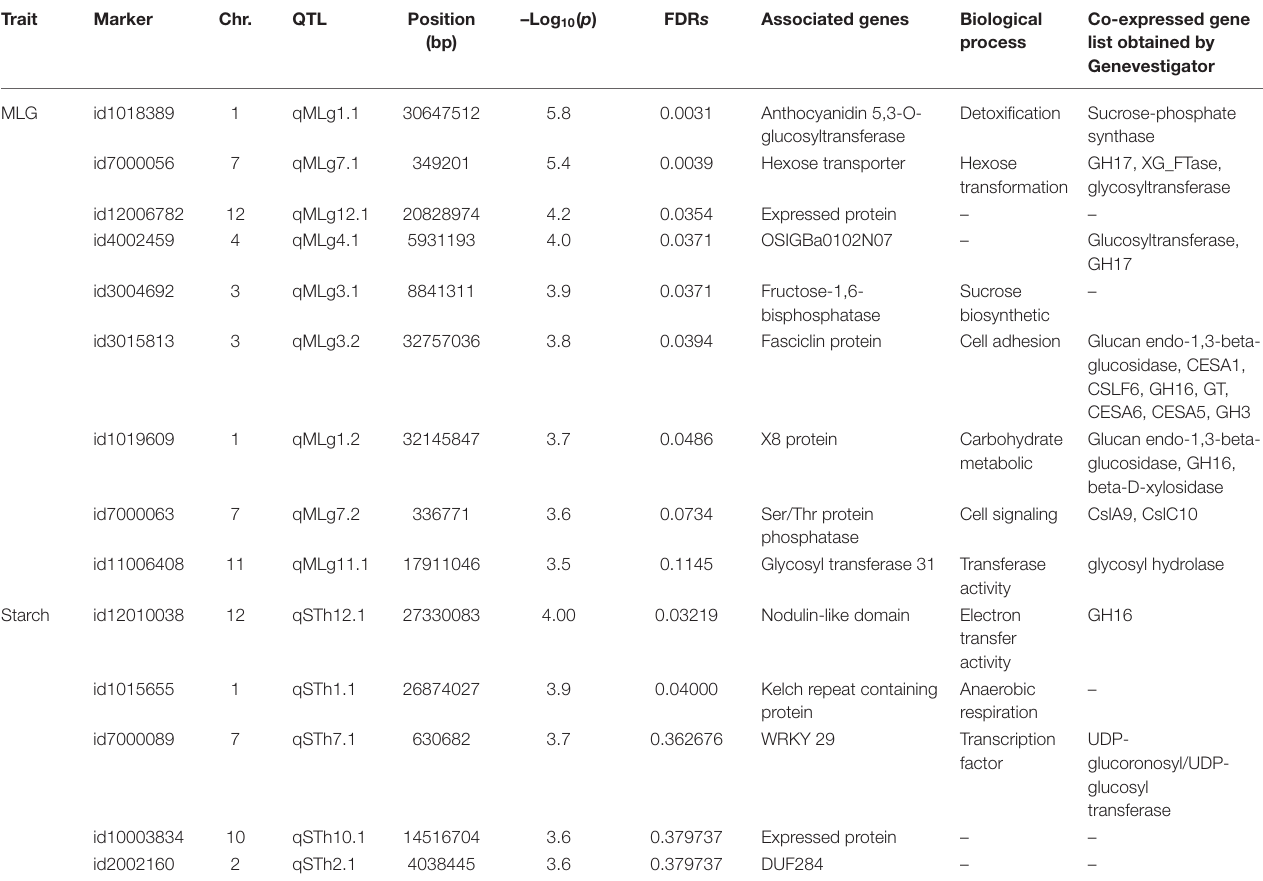
TABLE 2 | SNP association with MLG, starch, and biological function of associated genes. Trait Marker